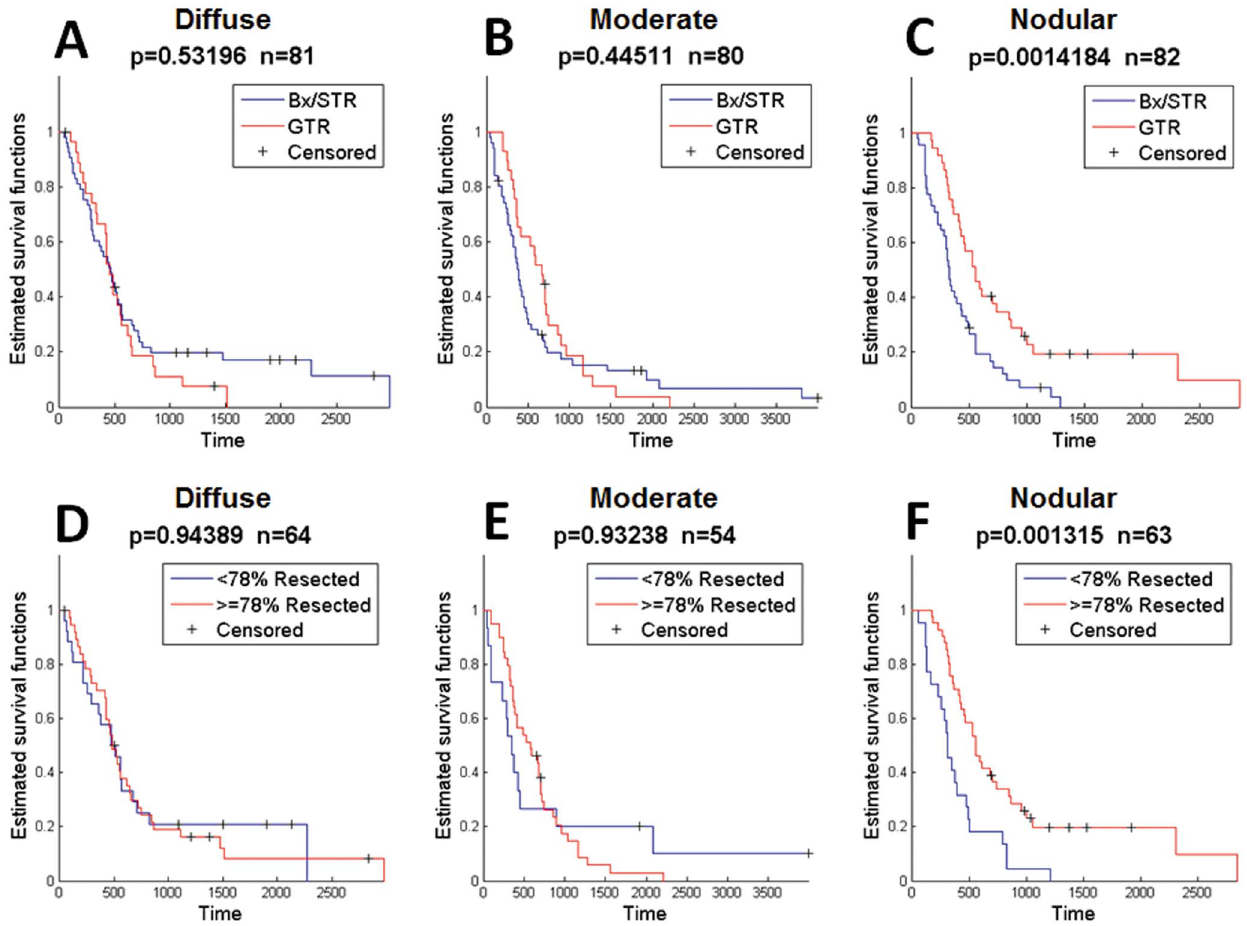
Figure 4. Survival Curves for Highly Diffuse (low r /D), Moderately Diffuse (mid r /D), and Nodular (high r /D) for 243 Contrast- enhancing Gliomas. Comparisons were made between biopsy/subtotal resection (BX/STR) and gross total resection (GTR) in all 243 contrast- enhancing gliomas. A–B) Comparing Bx/STR with GTR in 243 contrast enhancing gliomas at first surgical presentation, there is no significant survival benefit of GTR for highly and moderately diffuse (low and mid r /D, p=0.532, p=0.445, respectively). C) Patients with the least diffuse and most nodular pattern of growth (high r /D) that underwent GTR had a significant survival benefit over patients undergoing Bx or STR (p=0.00142). Median increase in survival was 227 days (7.5 months) or a 65% improvement over the BX/STR population. When EOR was classified by percent of the T1Gd volume removed, with 76% selected as the cut off, the same selective survival benefit is observed in the nodular cohort (D–F, p=0.00132). The limits between highly and moderately diffuse, and between moderately diffuse and nodular r /D were 0.376 mm 2 2 and 1.30 mm 2 2 ,